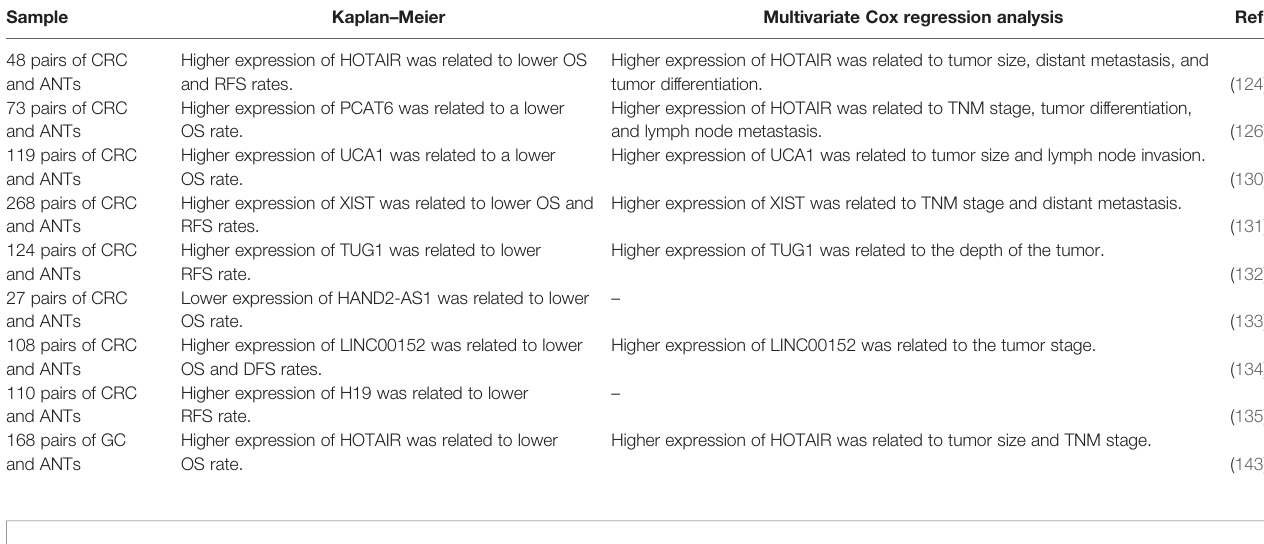
TABLE 8 | Prognostic roles of 5-FU-related lncRNAs (ANTm adjacent normal tissue; OS, overall survival; RFS, relapse-free survival). Sample